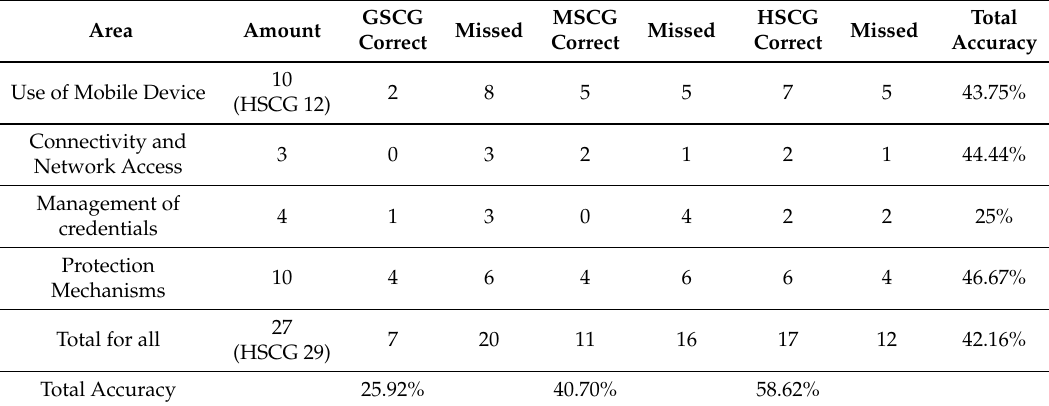
Table 4. Summary of prediction accuracy for the included